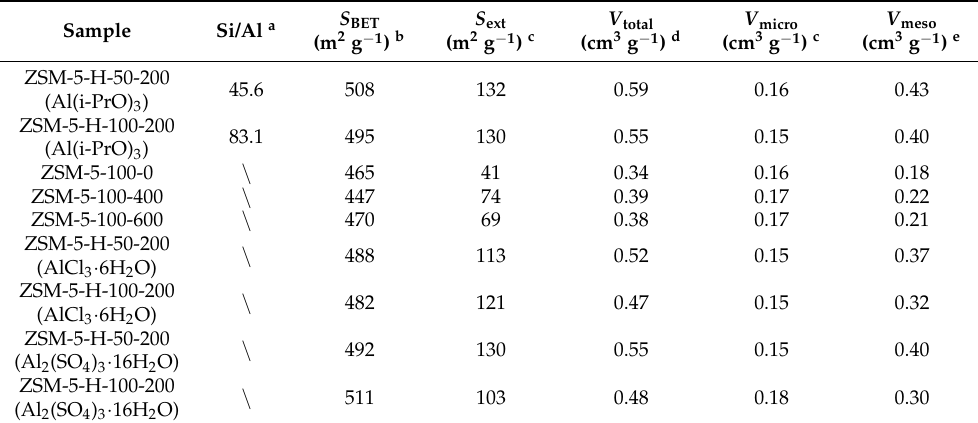
Figure 10. N 2 physisorption isotherms ( a ) and pore ‐ size distribution obtained by the NLDFT